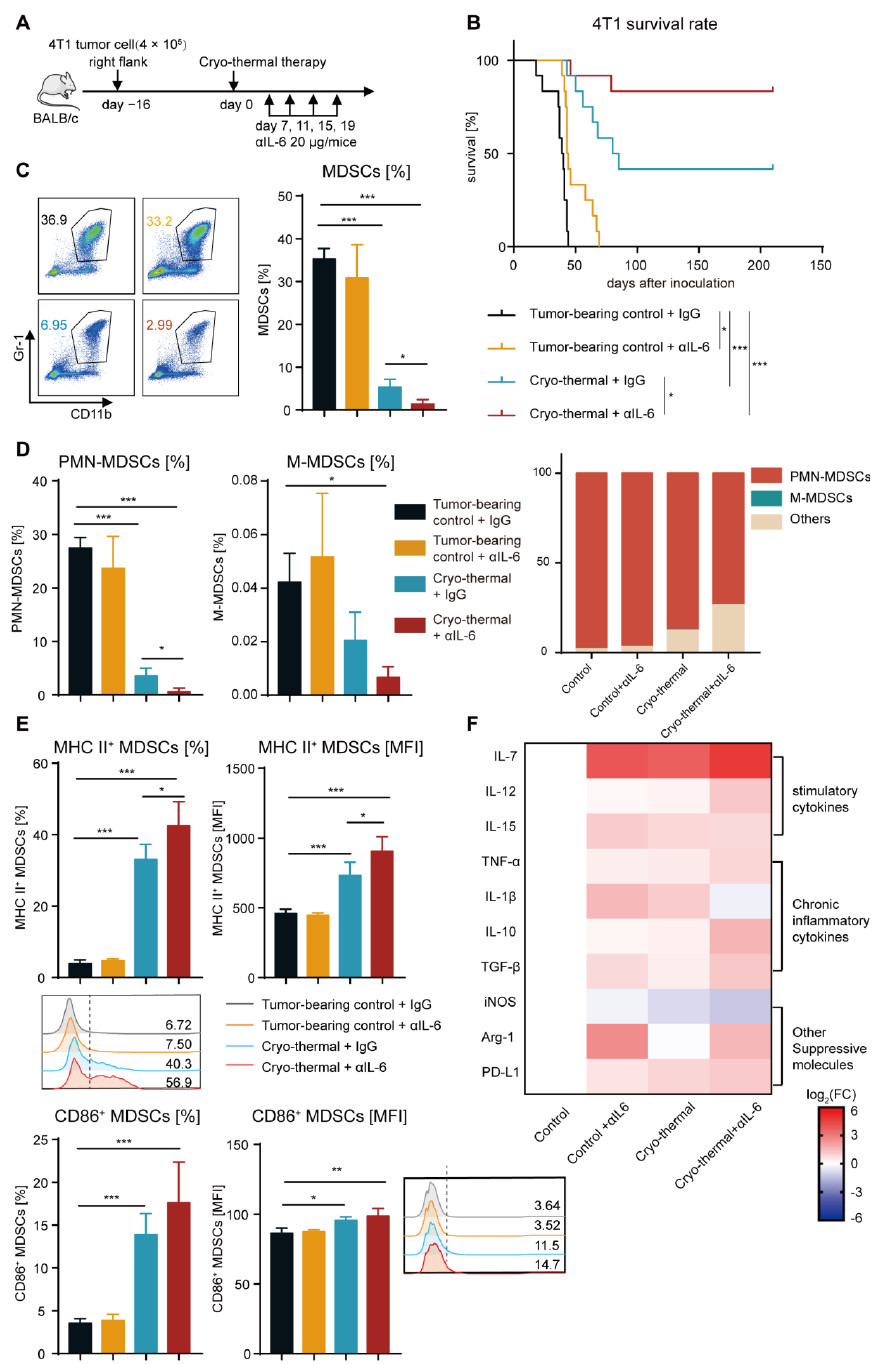
Figure 2. Combination therapy increased the survival rate of 4T1 breast cancer-bearing mice, reduced MDSC accumulation, and promoted MDSC maturation in the spleen. ( A ) Scheme of experiment design. ( B ) A Kaplan–Meier survival curve showed 4T1 breast cancer-bearing mice either treated with single anti-IL-6 mAb, cryo-thermal therapy or combination therapy, n = 12 per cohort, log-rank test was used to compare survival curve. ( C , D ) The proportion of MDSCs ( C ), PMN-MDSCs and M-MDSCs ( D ) in the spleen from tumor-beaing control + IgG (black), tumor-beaing control + α IL-6 (orange), cryo-thermal + IgG (blue), cryo-thermal + α IL-6 (red). ( E ) The mature phenotype of splenic MDSCs. ( F ) The mRNA levels of stimulatory and inhibitory genes in splenic MDSCs were analyzed by qRT-PCR n = 4 for each group. * p < 0.05, ** p < 0.01, *** p < 0.001. Data were analyzed using one-way